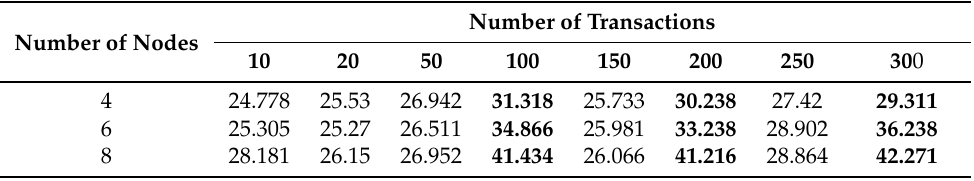
Table 3. Delay based on the PBFT consensus